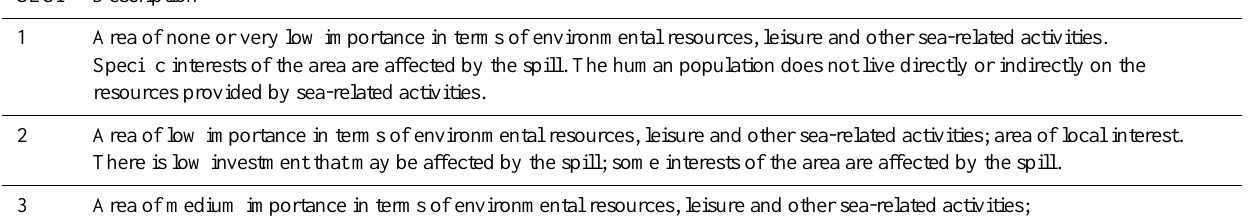
Table A2. Classes used for socio-economical index (SESI).